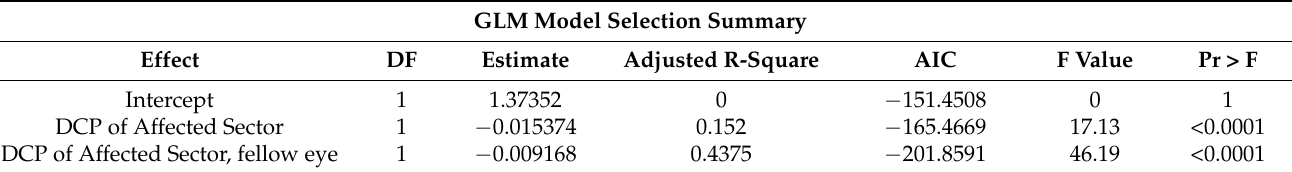
Table 4. Multivariate Analysis with Model Selection by General Linear Model (GLM). GLM Model Selection